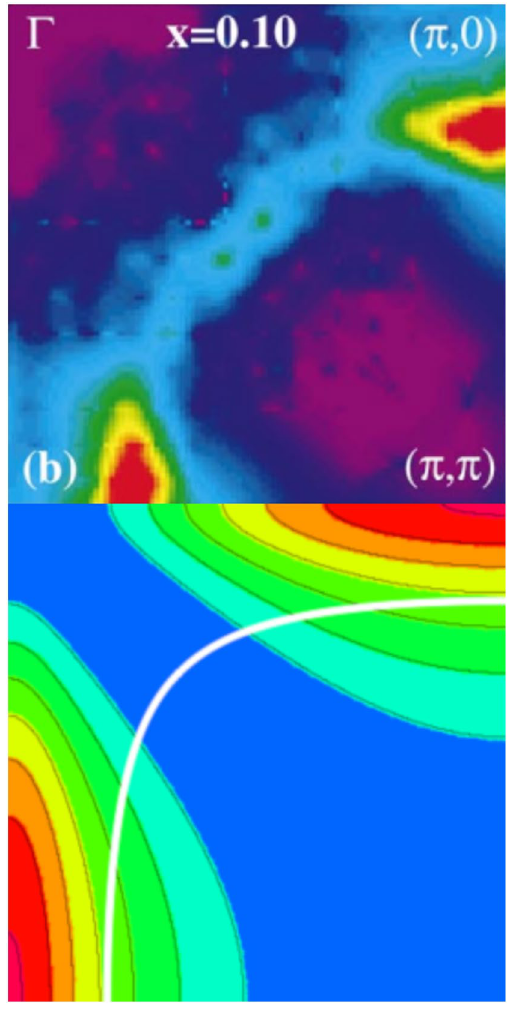
Fig. 3 Comparison of the scattering rate calculation in the frame‑ work of the s-d exchange calculation (bottom) with the ARPES data from Armitage et al. [53, Fig. 3 (b)] (top); reproduced with permis‑ sion. The momentum 𝐩 dependence of the ARPES intensity for elec‑ tron energies is close to the Fermi one. Continuous line in the theo‑ retical calculation (bottom) denotes the Fermi contour. The maxima in both figures correspond to hot spots from the phenomenology of Ref. [2]. The coincidence of hot and cold spots is the indispen‑ sable qualitative agreement before a detailed theory can be devel‑